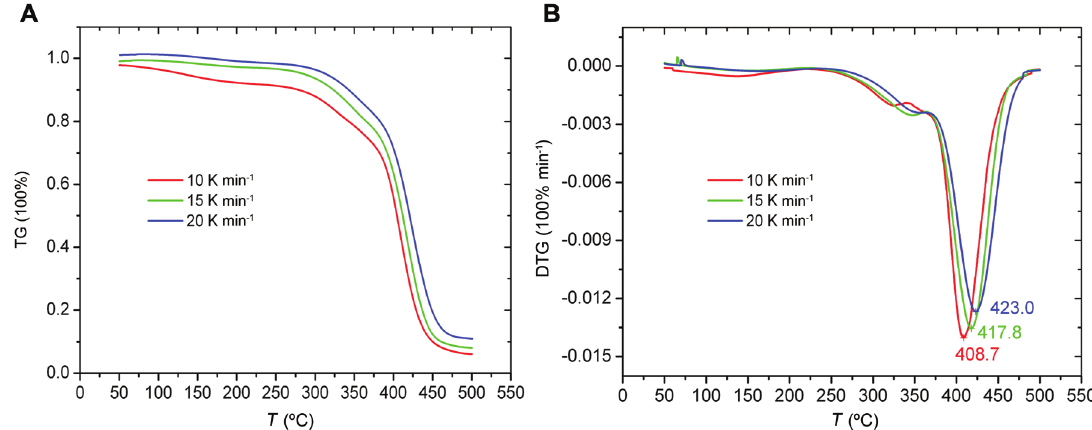
Figure 2 Thermal curves for the grafted epoxy resin: (A) TG, (B) DTG.